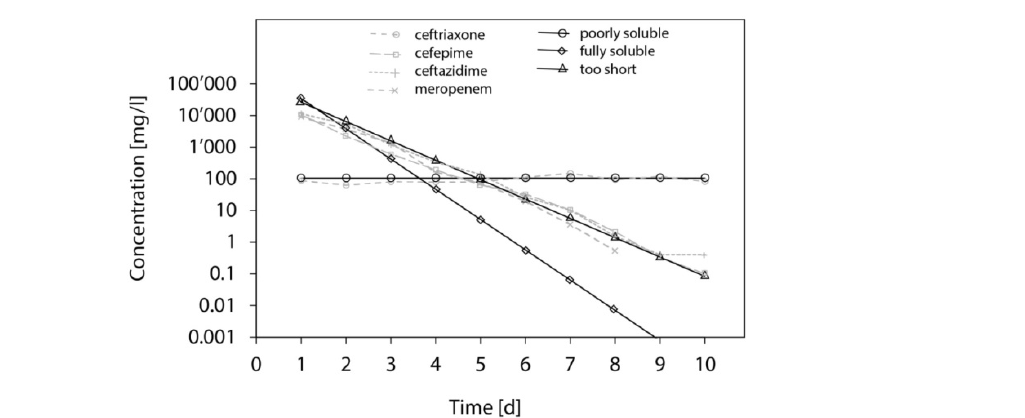
Figure 4. Results from determination of antibacterial activity by disc diffusion test, indicating the diameter of the zone of inhibition in mm. Data presented as means from triplicates, with error bars indicating standard deviation. In Fig. 4A, results of flucloxacillin, cefuroxime and ceftriaxone are shown. Fig. 4B provides the results for ciprofloxacin, levofloxacin and clindamycin. The horizontal line at 6 mm indicates the diameter of the paper disc. Direct comparison from one antibiotic to another shall not be made as different reference organisms have been used.